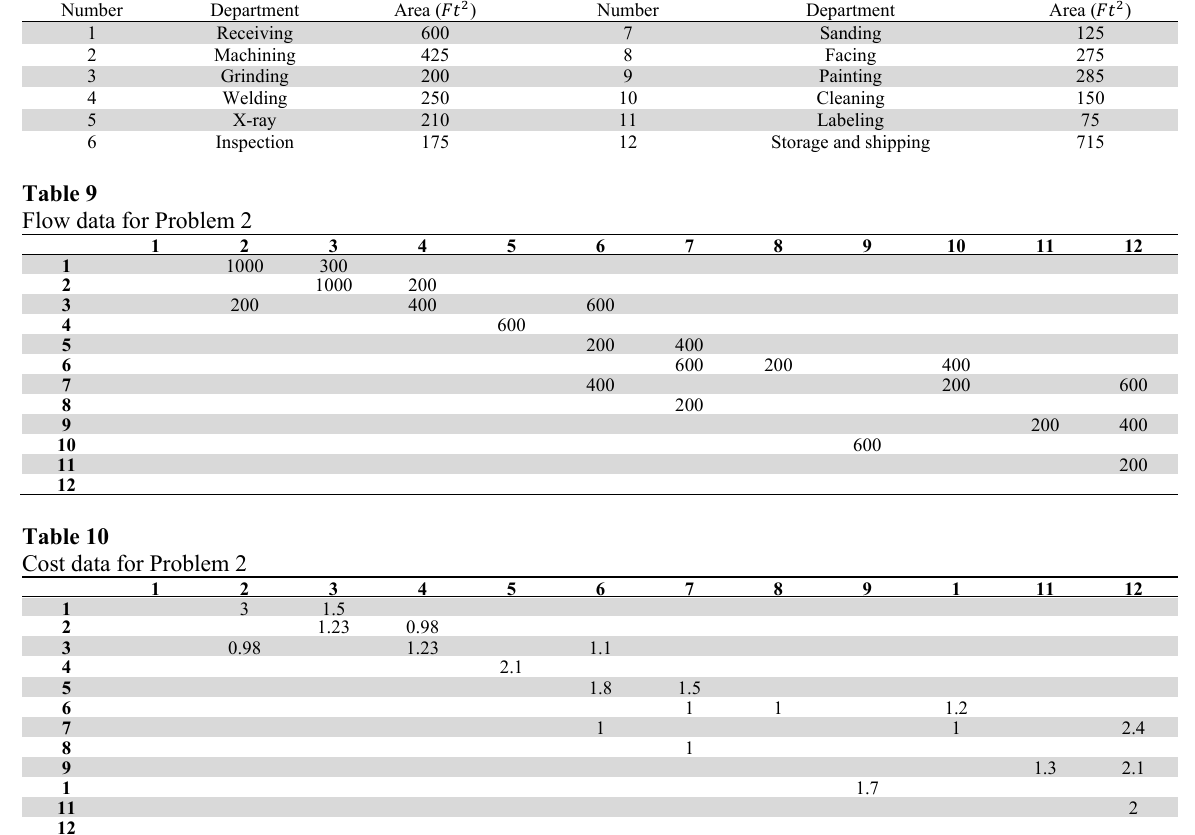
Departments and required areas in Problem 2